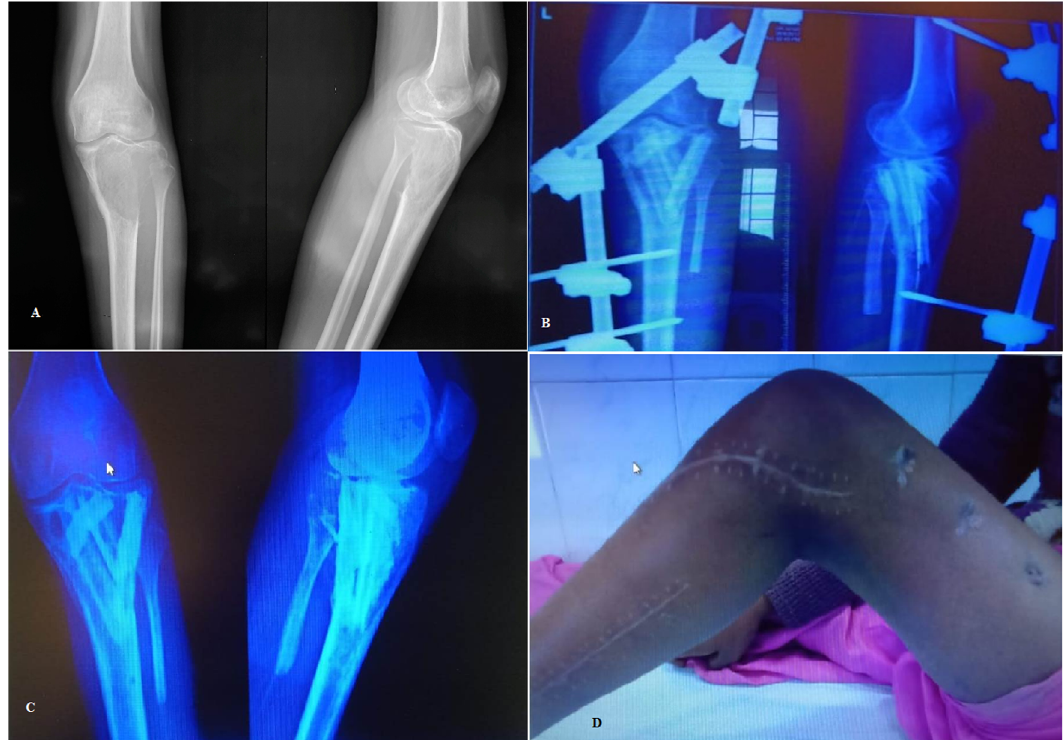
Figure 2. (A) Pre-operative radiographs of a Campanacci grade 3 GCT involving the proximal tibia; (B) Postoperative radiographs; (C) Follow up radiograph showing good graft uptake and no signs of tumor recurrence or penetration into joint; (D) Knee range of motion beyond 90 degrees at follow